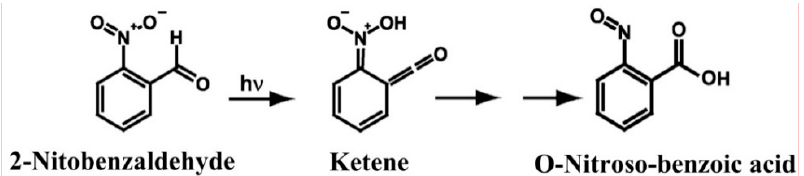
Figure S1: Structures of the phenothiazine dye methylene blue (MB), as well as the meso -tetrakis (tolyl)porphyrin derivatives H 2 (TTP) and (TTP)FeCl applied as photosensitizers; Figure S2: UV-vis spectra revealing the degree of anthracene photooxygenation by singlet oxygen (analyzed at λ max = 375 nm) in the presence of different concentrations of 2-nitrobenzaldehyde and MB as a photosensitizer after 45 min of visible-light irradiation using a combination of fluorescent lamps (maximum output at 419 nm and 575 nm); Figure S3: UV-vis spectra comparing the degree of anthracene photooxygenation by singlet oxygen (analyzed at λ max = 375 nm) with H 2 (TTP) acting as a photosensitizer in the absence and presence of 2-nitrobenzaldehyde. Conditions: 45 min of visible-light irradiation using a combination of fluorescent lamps with lamps (maximum output at 419 nm and 575 nm); Figure S4: UV-Vis spectra comparing the degree of anthracene photooxygenation by singlet oxygen (analyzed at λ max = 375 nm) with (TTP)FeCl as a photosensitizer in the absence and presence of 2-nitrobenzaldehyde. Conditions: 45 min of visible-light irradiation using a combination of fluorescent lamps with lamps (maximum output at 419 nm and 575 nm); Figure S5: UV-Vis spectra showing the photodegradation of MB ( λ max = 655 nm) in the presence of different nitrobenzaldehyde derivatives (1 mmol) after 24 h of UV-light irradiation with 300 nm fluorescent lamps; Figure S6: UV-Vis spectra showing the photodegradation of MB ( λ max = 655 nm) in the presence of different concentrations of 2-nitrobenzaldehyde (1.0 mmol, 0.5 mmol) after 24 h of UV-light irradiation with 300 nm fluorescent lamps; Figure S7: UV-Vis spectra showing the photodegradation of MB ( λ max = 655 nm) in the presence and in the absence of 2-nitrobenzaldehyde after 24 h of irradiation with 419 nm fluorescent lamps; Figure S8: UV-Vis spectra showing the photodegradation of MB ( λ max = 655 nm) in the presence and in the absence of 2-nitrobenzaldehyde after 24 h of irradiation with 575 nm fluorescent lamps; Figure S9: Photochemical reactor applied for the present study (https://rayonet.org/reactors.php?part=RPR-100).